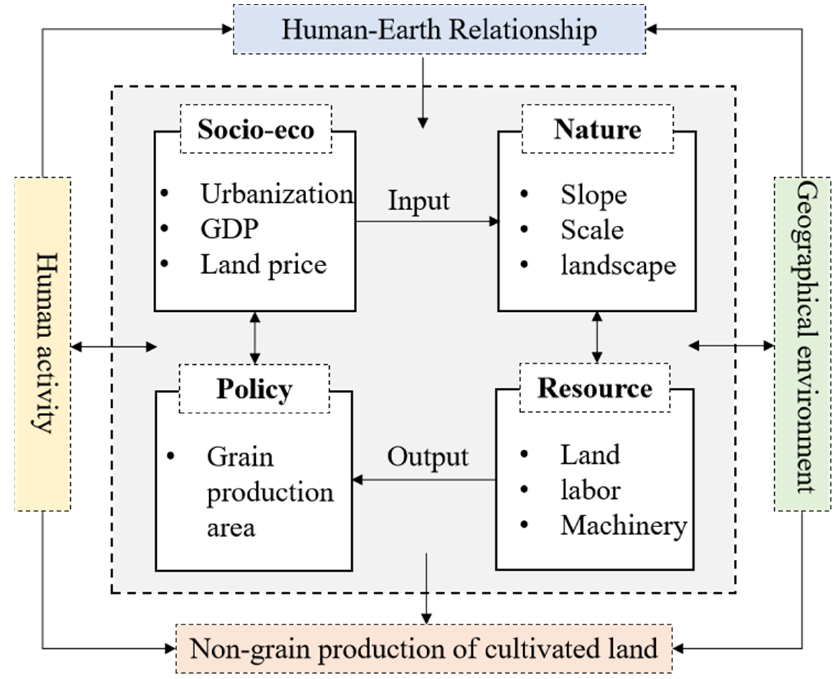
Figure 2. Framework of the influencing factors of NGPCL. Table 1. Description of the influencing factors.